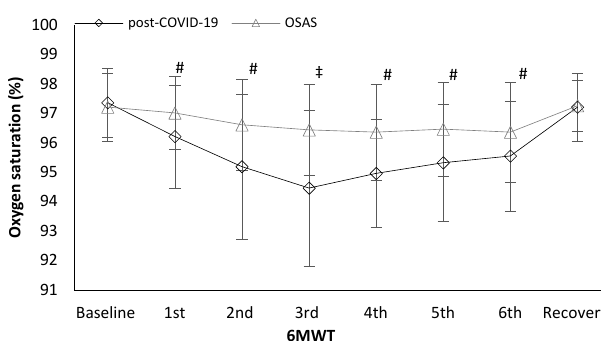
and body composition parameters (muscle mass: r = 0.492, p = 0.001 Figure 5; body mass: r = 0.508, p = 0.001; lean body mass: r = 0.634, p < 0.001; percent of body fat: r = − 0.457, p = 0.003; total body water: r = 0.572, p < 0.001; visceral fat: r = 0.429, p = 0.006; WHR: r = 0.465, p = 0.002; ∆ chest: r = 0.379, p = 0.016); O 2 saturation at the end of the 6MWT Figure 3. Oxygen saturation alteration during the 6 min walk (6MWT) test between the groups. # (6th minute: r = − 0.333, p = 0.039); and estimated O 2 uptake (r = 0.538, p < 0.001). <0.005, ‡ <0.001.